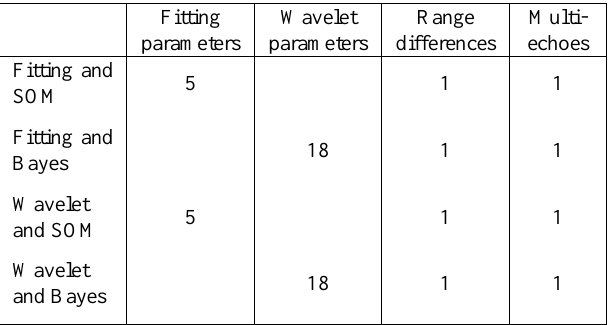
Table 1: Used parameters for